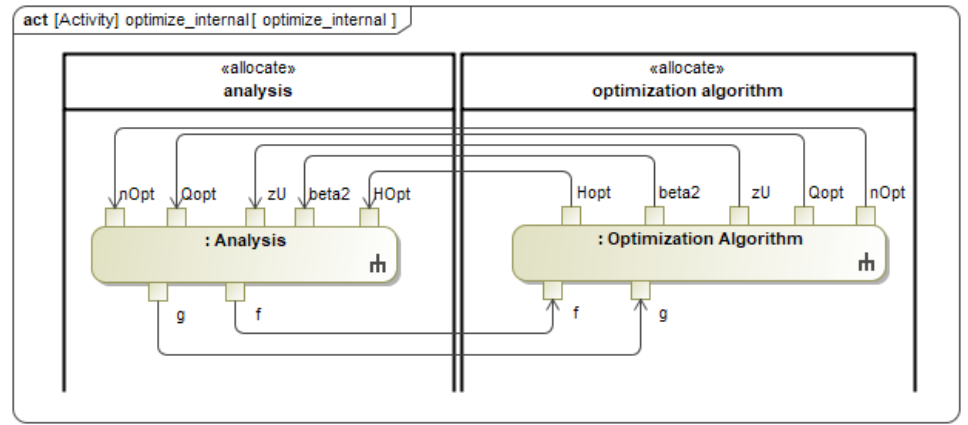
Figure 11. Internal behavior of the workflow element optimize.